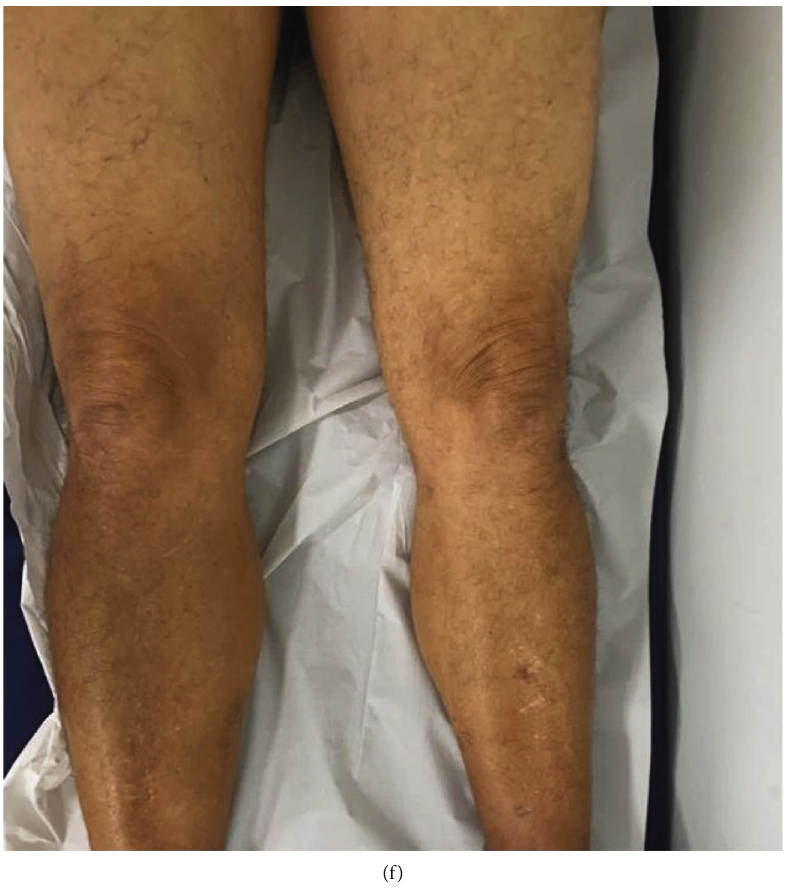
Figure 1: (a) Androgenetic alopecia. (b) Hirsutism (recent depilation). (c) Hirsutism and grade 1 acne on the face. (d) Hirsutism on the abdomen (approximately 4 points on the Ferriman – Gallwey scale). (e) Clitoromegaly and hirsutism on the vulvar region (recent depilation). (f) Male pattern hair growth on the lower limbs. Table 1: Initial laboratory tests conducted in a 64-year-old woman with signs of hyperandrogenism.